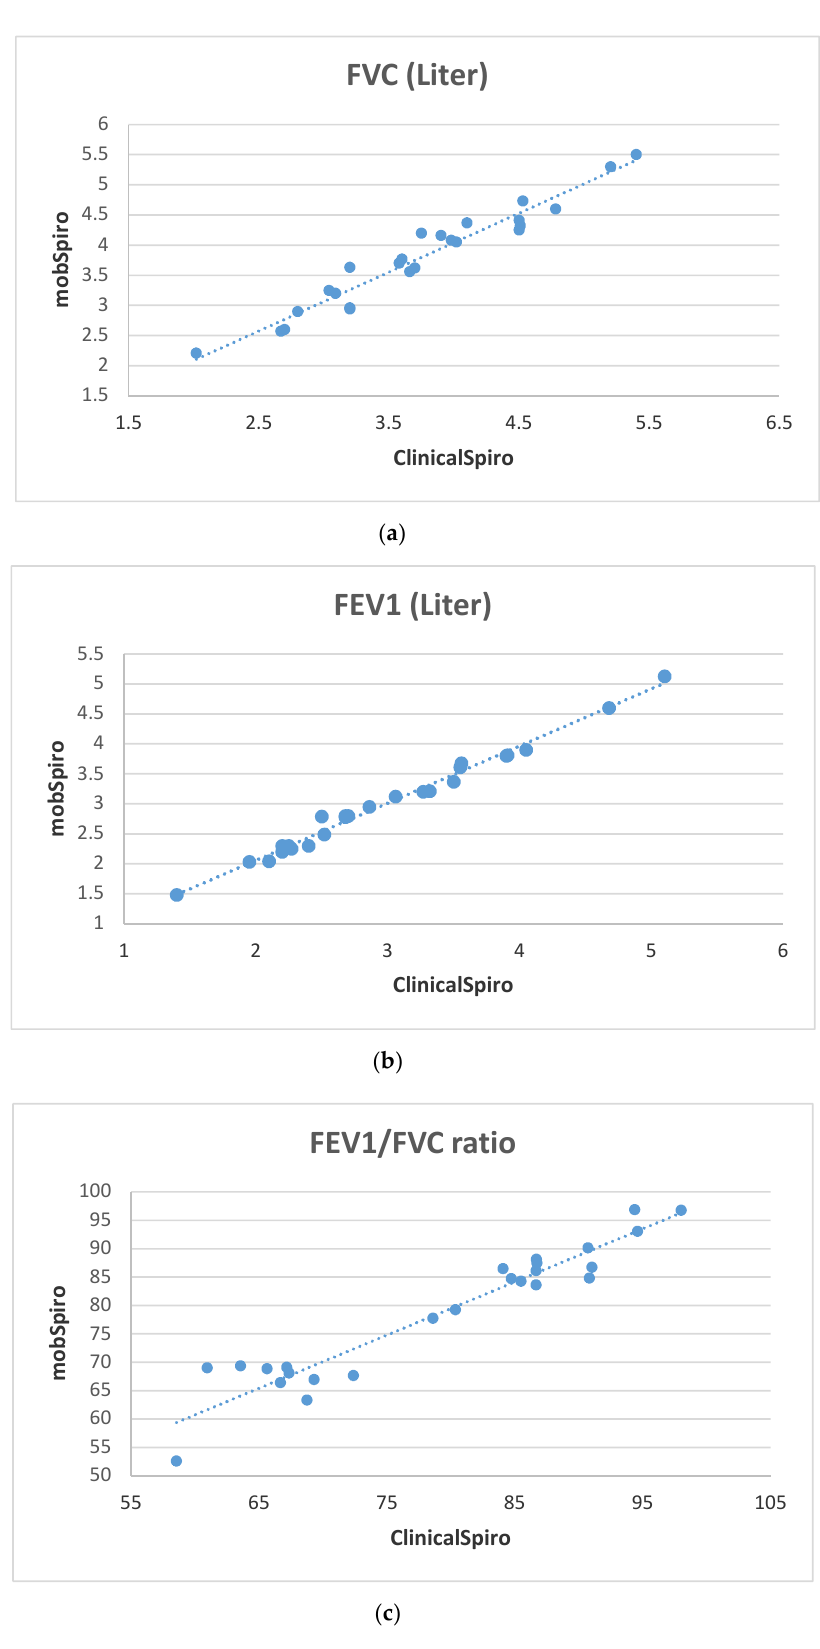
Figure 9. Correlation Graphs of mobSpiro vs ClinicalSpiro for ( a ) FVC, ( b ) FEV1, ( c ) FEV1/FVC. Table 3. Diagnosis Results of the Patients.